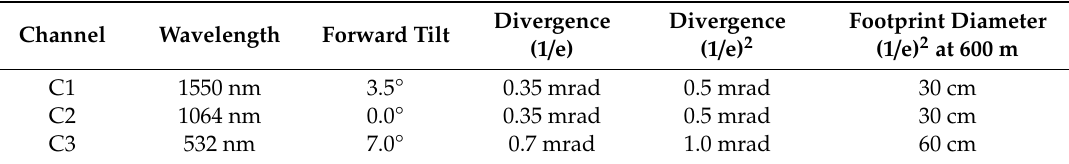
Table 1. Titan sensor laser characteristics and footprint diameter at 600 m